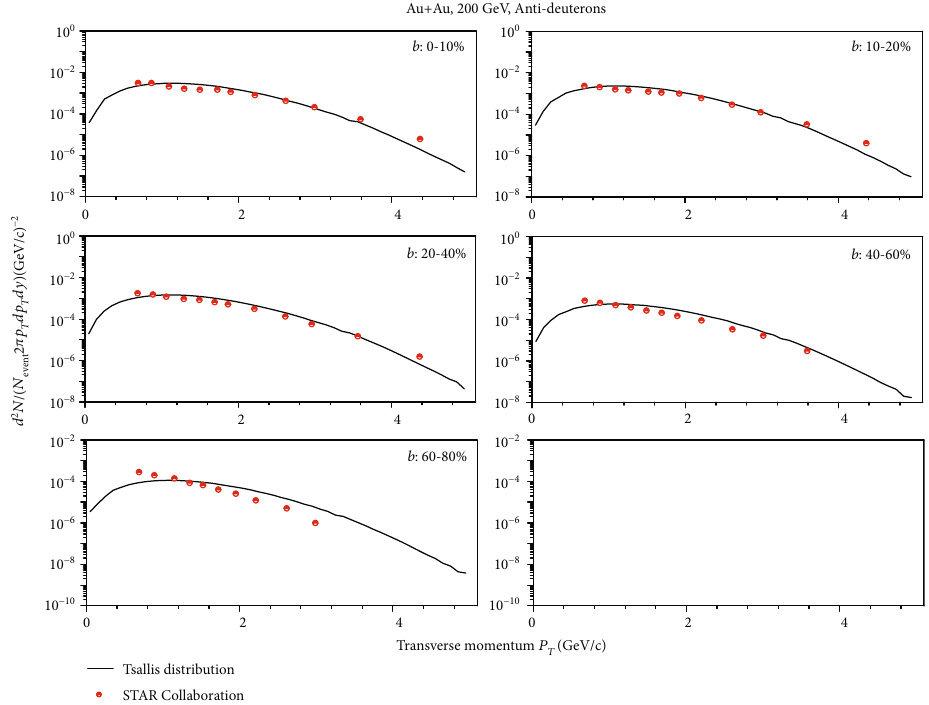
ffiffiffiffiffiffiffi p = 200 GeV for 0-10%, 10-20%, 20-40%, 40-60%, and 60- s NN